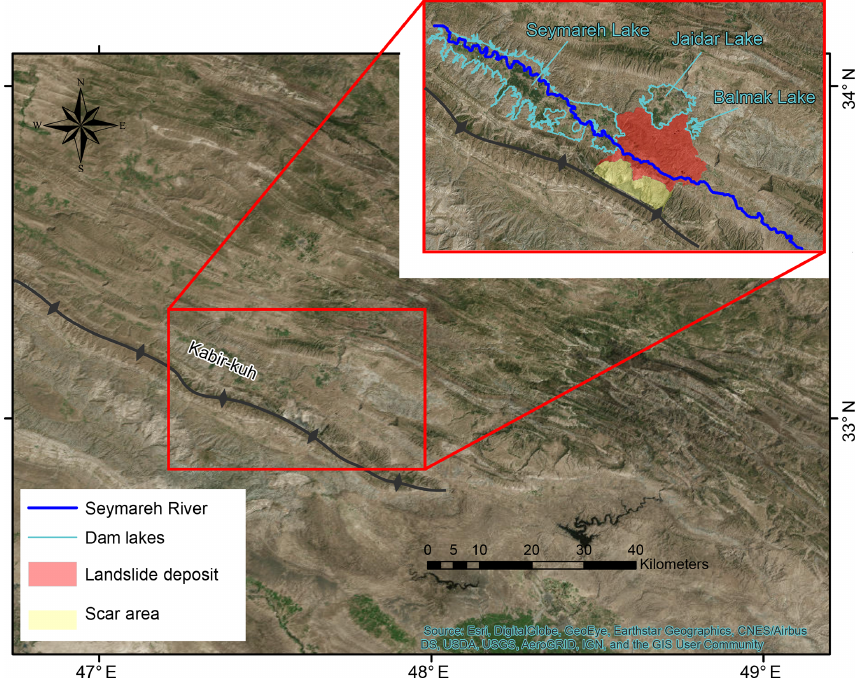
Figure 4. Overview and zoomed-in view (in the red box) of the Seymareh landslide, Zagros Fold–Thrust Belt, NW Iran (modified from © Google